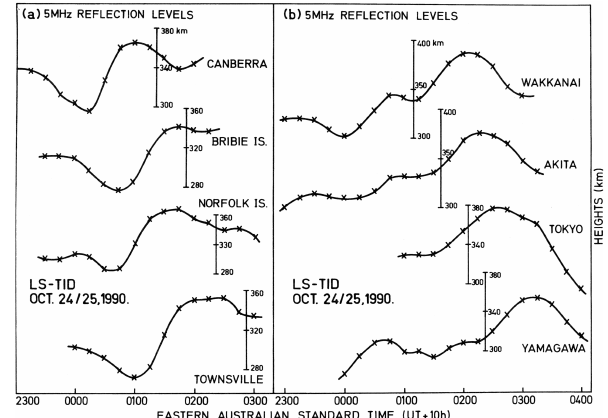
Fig. 3. A reproduction of Fig. 2 of Bowman (1992) showing LS- TID propagation (a) in Australia involving a speed of 507ms − 1 and (b) in Japan where the speed was 443ms − 1